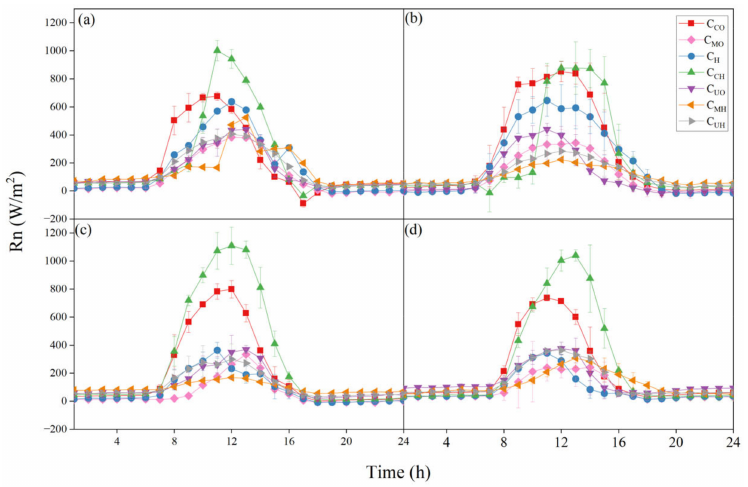
Figure 3. Diurnal variations in net radiation ( Rn ) above seven riparian communities in spring ( a ), summer ( b ), autumn ( c ) and winter ( d ). The bars show the standard deviations of Rn